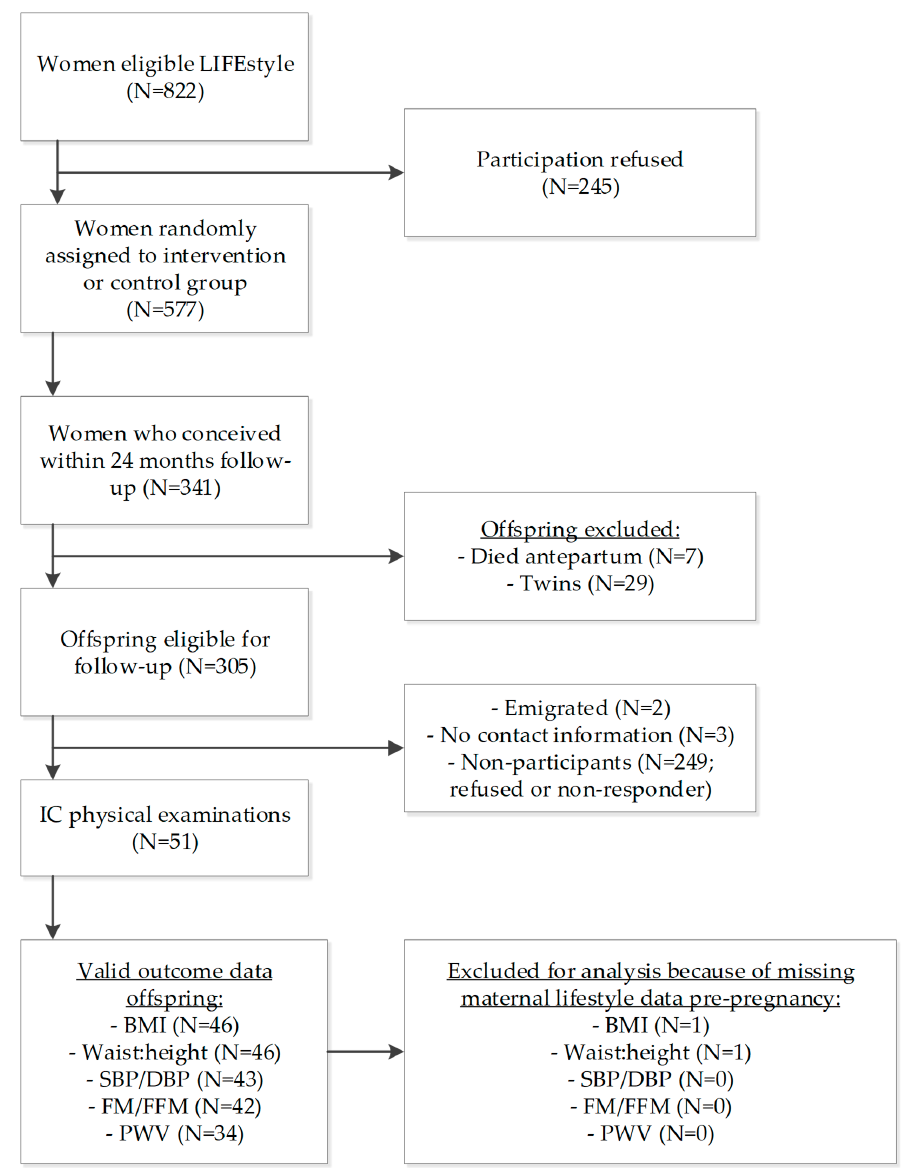
Figure 1. Flow-chart of the women and their offspring included in this study; IC = informed consent. Total numbers of participants used for analysis differ per dependent/independent variable based on available data.